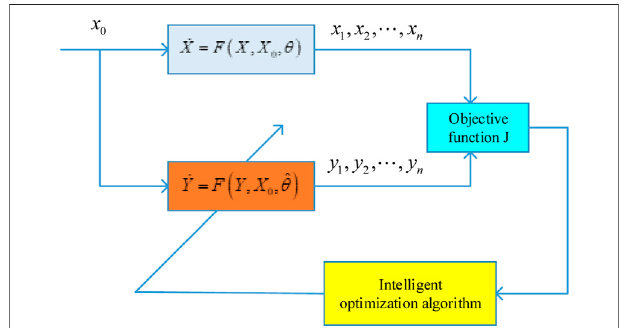
FIGURE 1 | Identi fi cation principle of a chaotic system [20].